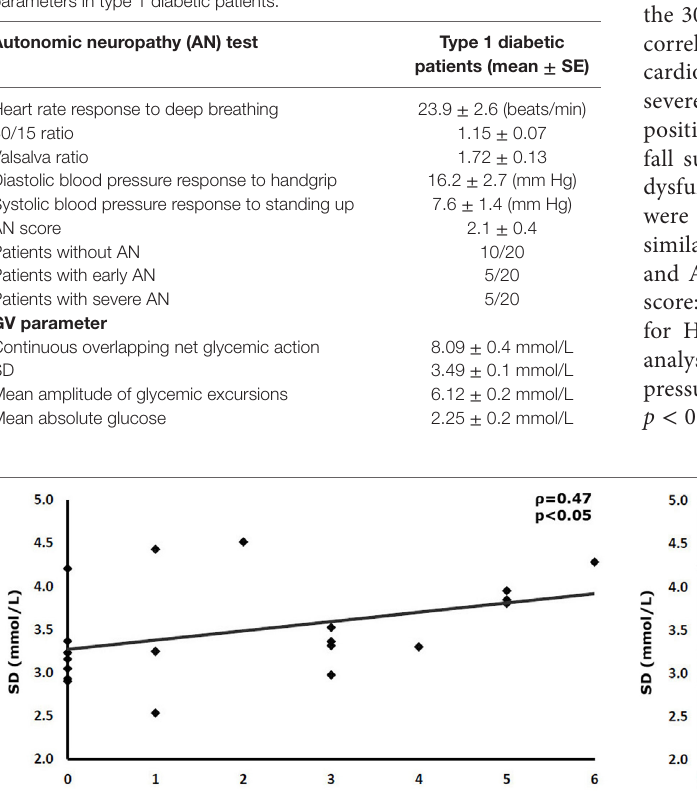
Table 1 | Results of cardiovascular reflex tests and glucose variability parameters in type 1 diabetic patients.